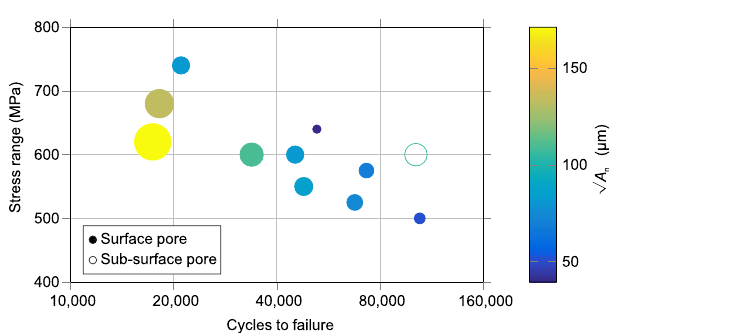
Figure 3. Effect of pore size on fatigue life – S-N curve showing only those samples that failed from porosity for samples tested in the z -direction. The size and colour of the markers indicate the size of the pore ( A n ) measured from SEM images of the fracture